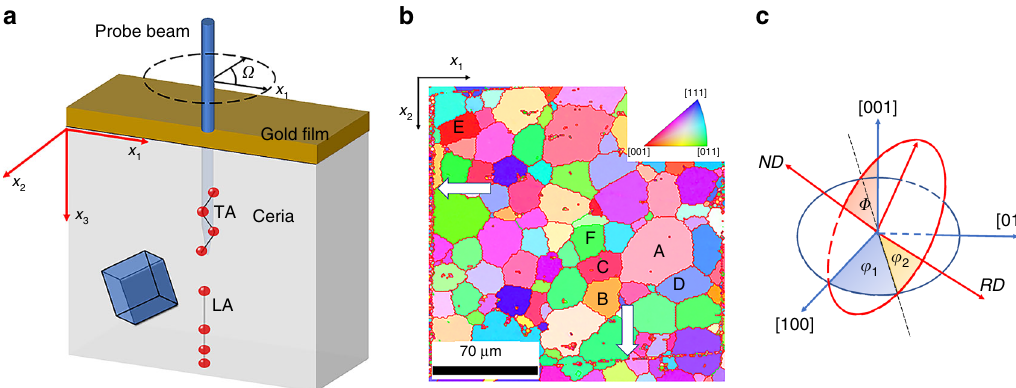
Fig. 1 Time domain Brillouin Scattering experiments on speci fi c crystallites in polycrystalline CeO 2 . a Geometry of ceria sample. b EBSD of sample surface. The orientation of crystallites denoted by letters A – F is given in Table 1. The platinum fi ducial square, delineated by white arrows, is used to de fi ne the laboratory coordinate system. c The three Euler angles are used to de fi ne the crystallite orientation relative to the laboratory coordinate system. The fi rst rotation, φ φ 1 , is about [001] and the last rotation, 2, is about